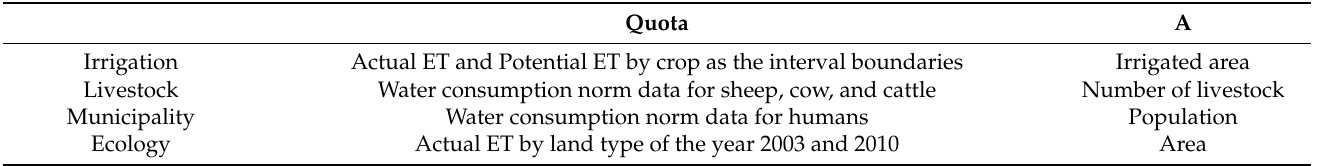
Table 5. Associated data for the calculation of water demand. Quota A